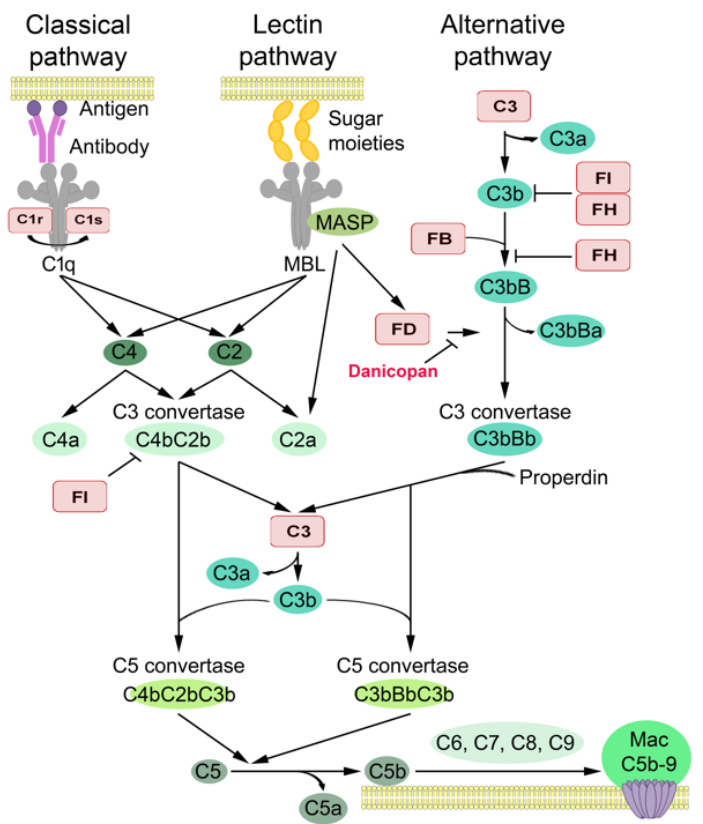
Figure 6. Complement components in cSCC. The complement may be activated via the classical, lectin or alternative pathway. The complement components and inhibitors shown to promote the progression of cSCC are highlighted in red. C3, FB and FI promote cSCC tumor growth in vivo [26,27]. C1r and C1s promote tumor growth and vascularization of cSCC xenograft tumors in vivo [28]. C3, FB, C1r, C1s, FI and FH increase cSCC cell viability, proliferation and migration in culture [25–28]. C1r and FI promote invasion of cSCC cells; C1r by increasing expression of MMP-13, MMP-1, MMP-10 and MMP-12 and FI by increasing expression of MMP-13 and MMP-2 [29,30]. FD regulates the proliferation of cSCC cells, and the specific inhibitor of FD (danicopan; ACH-4471) inhibits the proliferation of cSCC cells in a dose-dependent manner. Modified from [11].